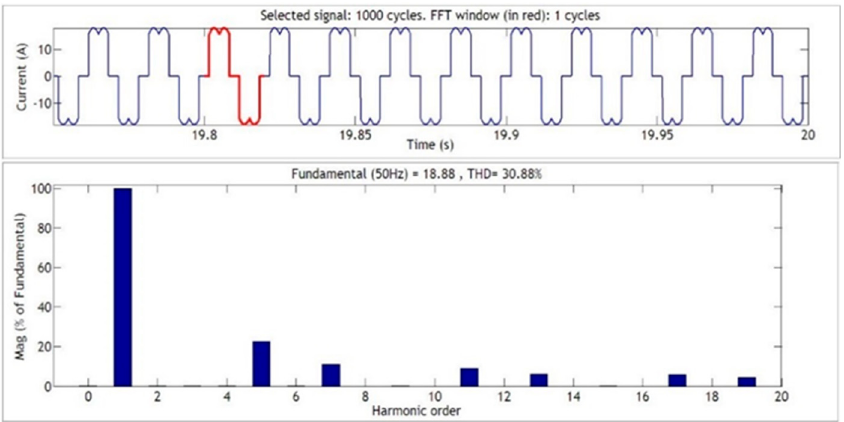
Figure 9. Before compensation source current FFT analysis.